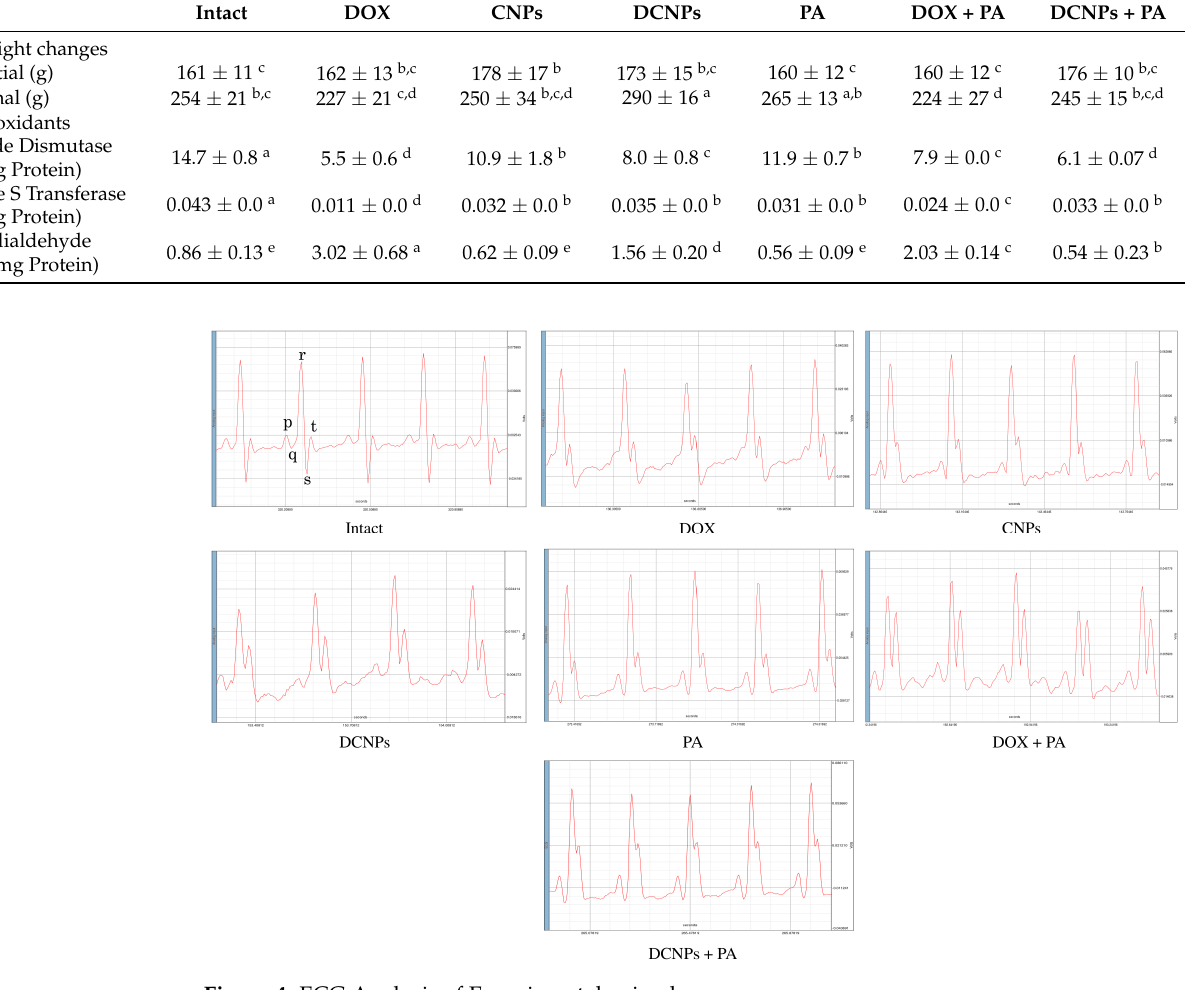
Figure 4. ECG Analysis of Experimental animals.